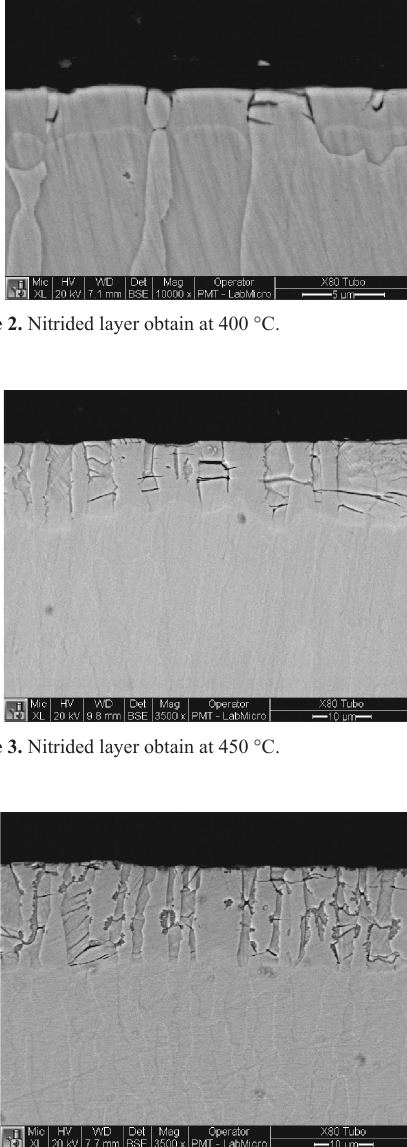
Figure 4. Nitrided layer obtain at 500